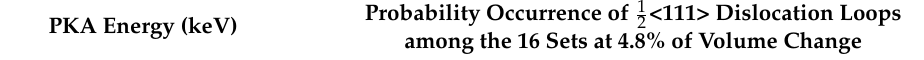
Table 1. Dislocation occurrence probability (i.e., how many times dislocation appeared among the 16 different simulation sets). The only formed dislocation was 1 <111> type. 2 Probability Occurrence of 1 <111> Dislocation Loops 2 PKA Energy (keV) among the 16 Sets at 4.8% of Volume Change